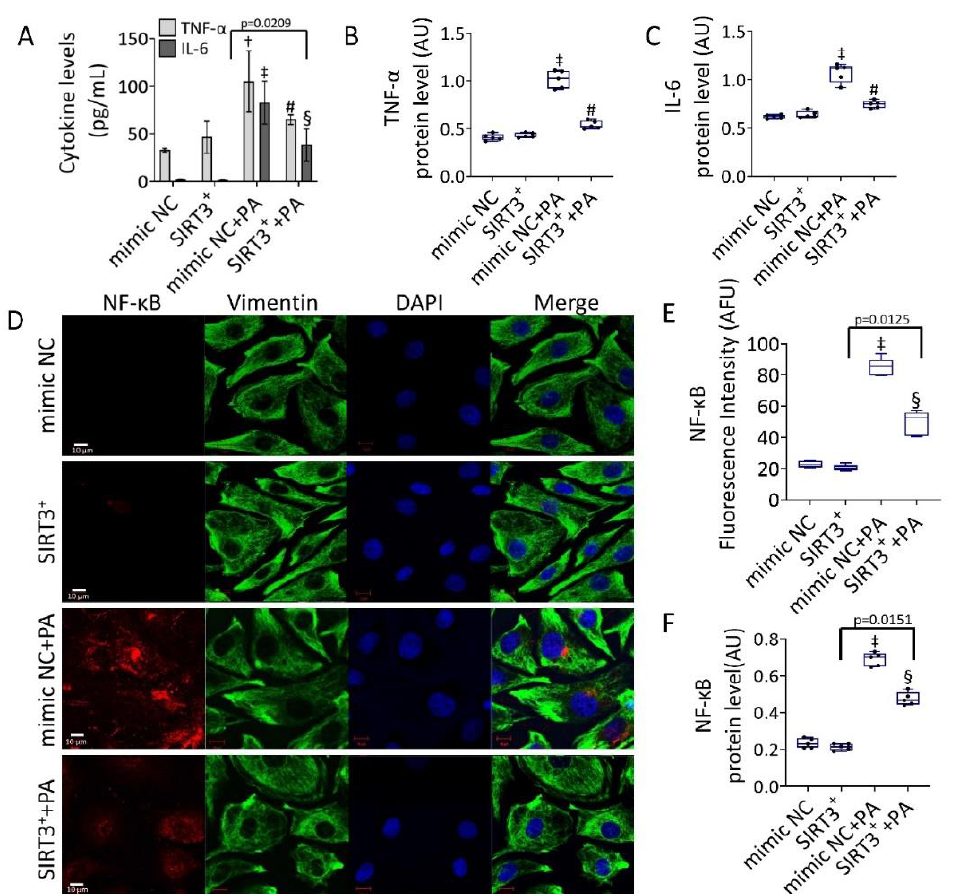
Figure 4. SIRT3 + counteracted the PA-induced inflammation. ( A ) Cytokine content and protein level of ( B ) TNF- α , and ( C ) IL-6. ( D ) Representative images of confocal laser scanning microscopy (scale bars = 10 µm). ( E ) Fluorescence intensity and ( F ) protein expression levels of NF- κB in EC transfected with mimic Negative Control (mimic NC), SIRT3 mimic (SIRT3 + ), mimic Negative Control and then exposed to 0.5 mM PA for 48 h (mimic NC+PA) or SIRT3 mimic before 48 h treatment with PA (SIRT3 + +PA). Fluorescence analysis is reported as boxplots of arbitrary fluorescence units (AFU) of 5 independent experiments. Densitometric immunoblotting study ( n = 5) is expressed as arbitrary units (AU). † p < 0.01 vs. mimic NC; ‡ p < 0.001 vs. mimic NC; § p < 0.05 vs. mimic NC+PA; # p < 0.01 vs. mimic NC+PA.